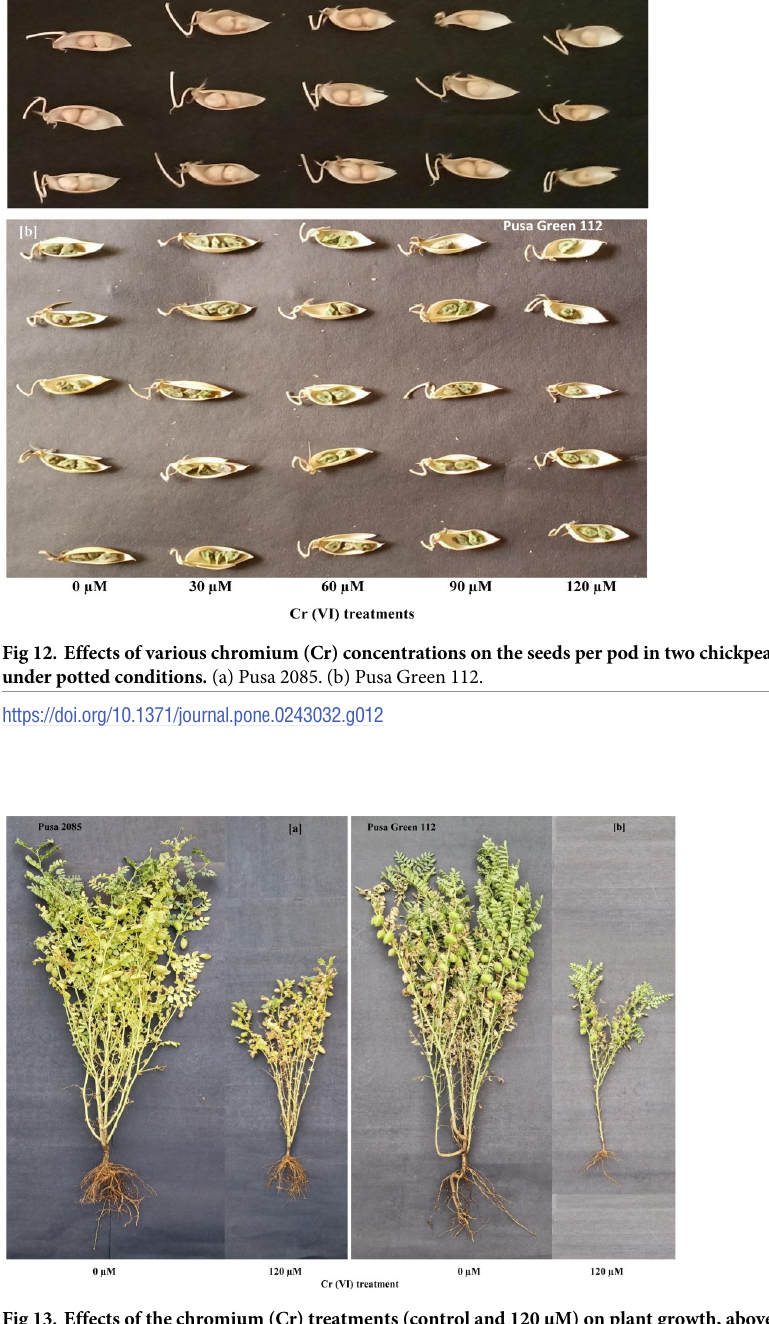
PLOS ONE | https://doi.org/10.1371/journal.pone.0243032 December3,